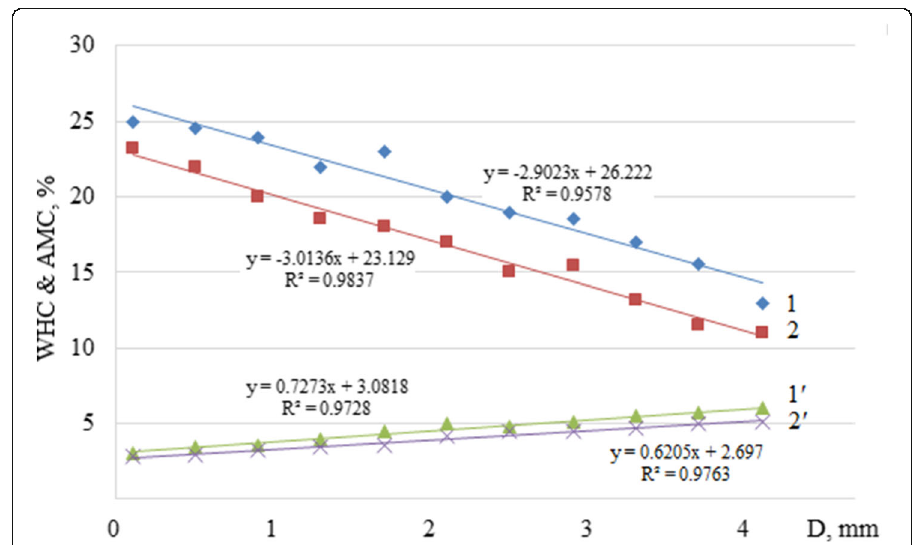
Fig. 8 Dependence of the WHC and AMC indicators of HVG granulate on its grain size. 1 — WHC of GPIS and FPIS granulated melt, 2 — WHC of LCCESS granulate, 1 ′— AMC of GPIS and FPIS granulate, 2 ′— AMC